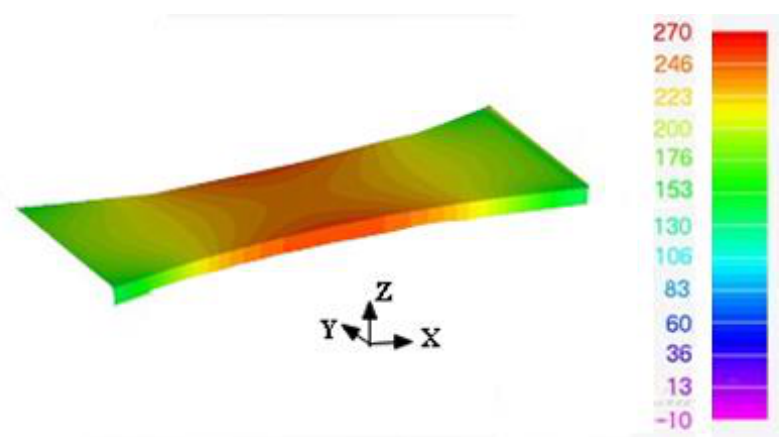
Figure 4. The computed stress field in the fine mesh finite element model at a remote load of 29 kN. The stress units in the picture are in MPa.